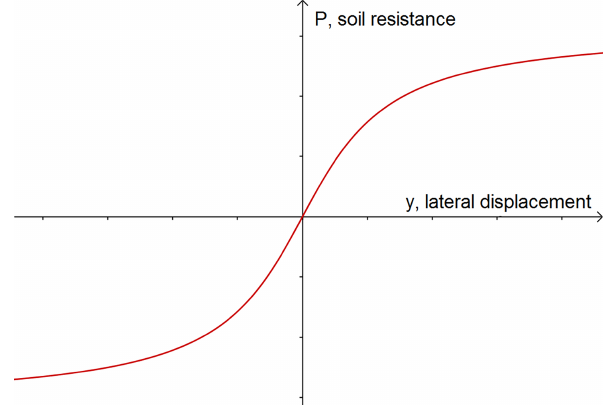
Figure 3. Typical shape of p – y curves for sand.